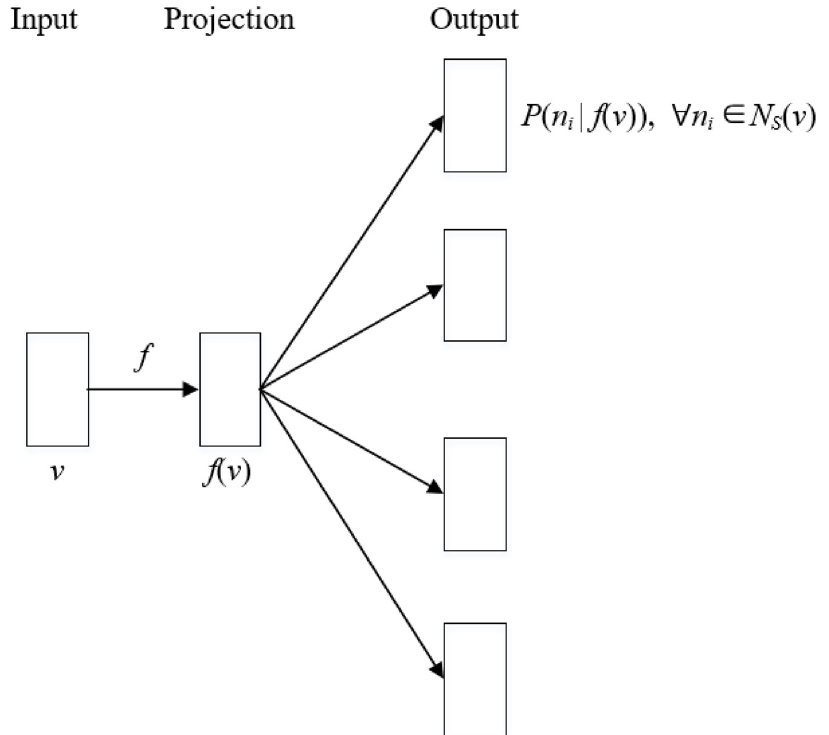
Fig 3. Illustration of the skip-gram